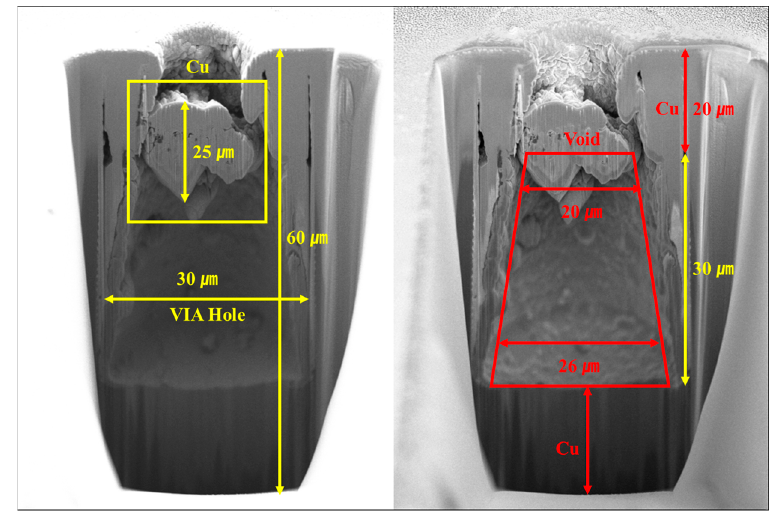
Figure 12. FIB Cross-section image of TSV.